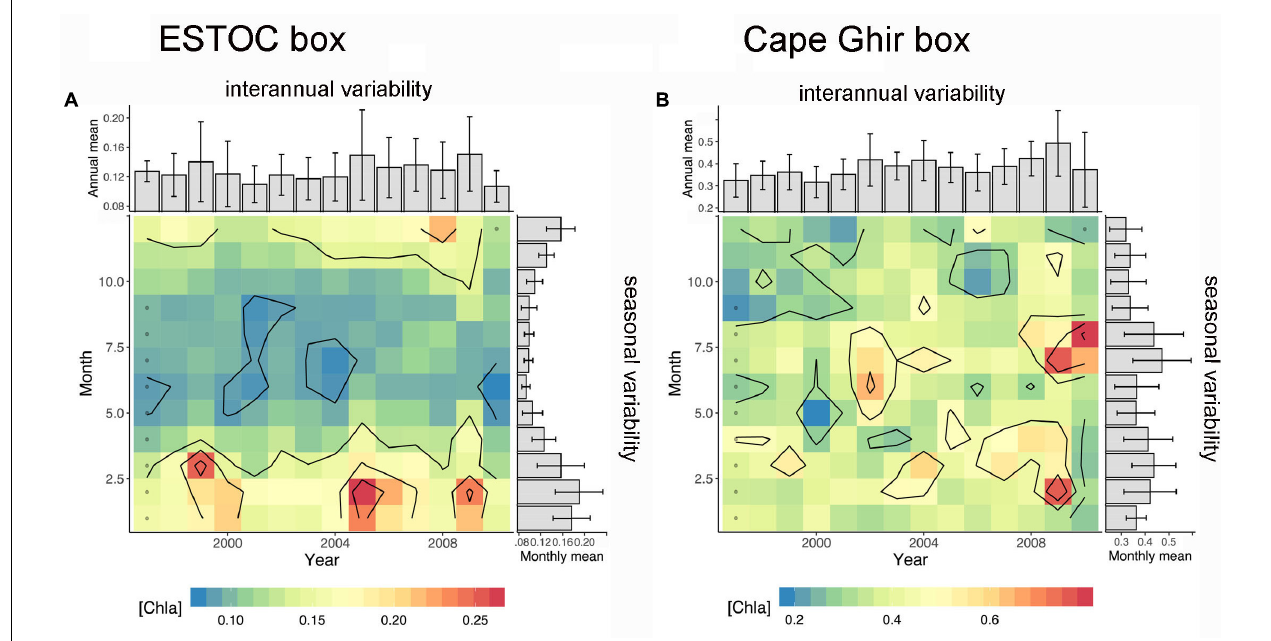
FIGURE 9 | Seasonal vs. interannual variability of SeaWiFs-chlorophyll for the ESTOC (A) and the Cape Ghir box (B) . Note the difference in seasonality between both boxes (summer maximum at Cape Ghir) and the long term increasing trend in chlorophyll from 1997 to 2010 mainly off Cape Ghir. Gray dots represent the squares interpolated by the Barnes